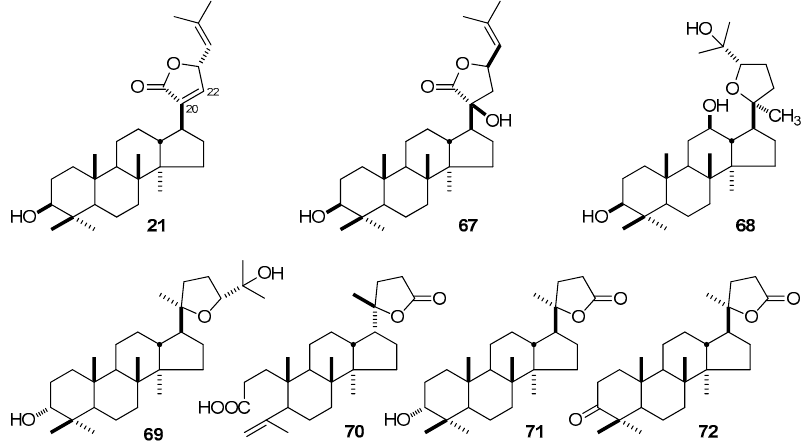
Figure 7. The structure of compounds 21 , 67 – 72 .